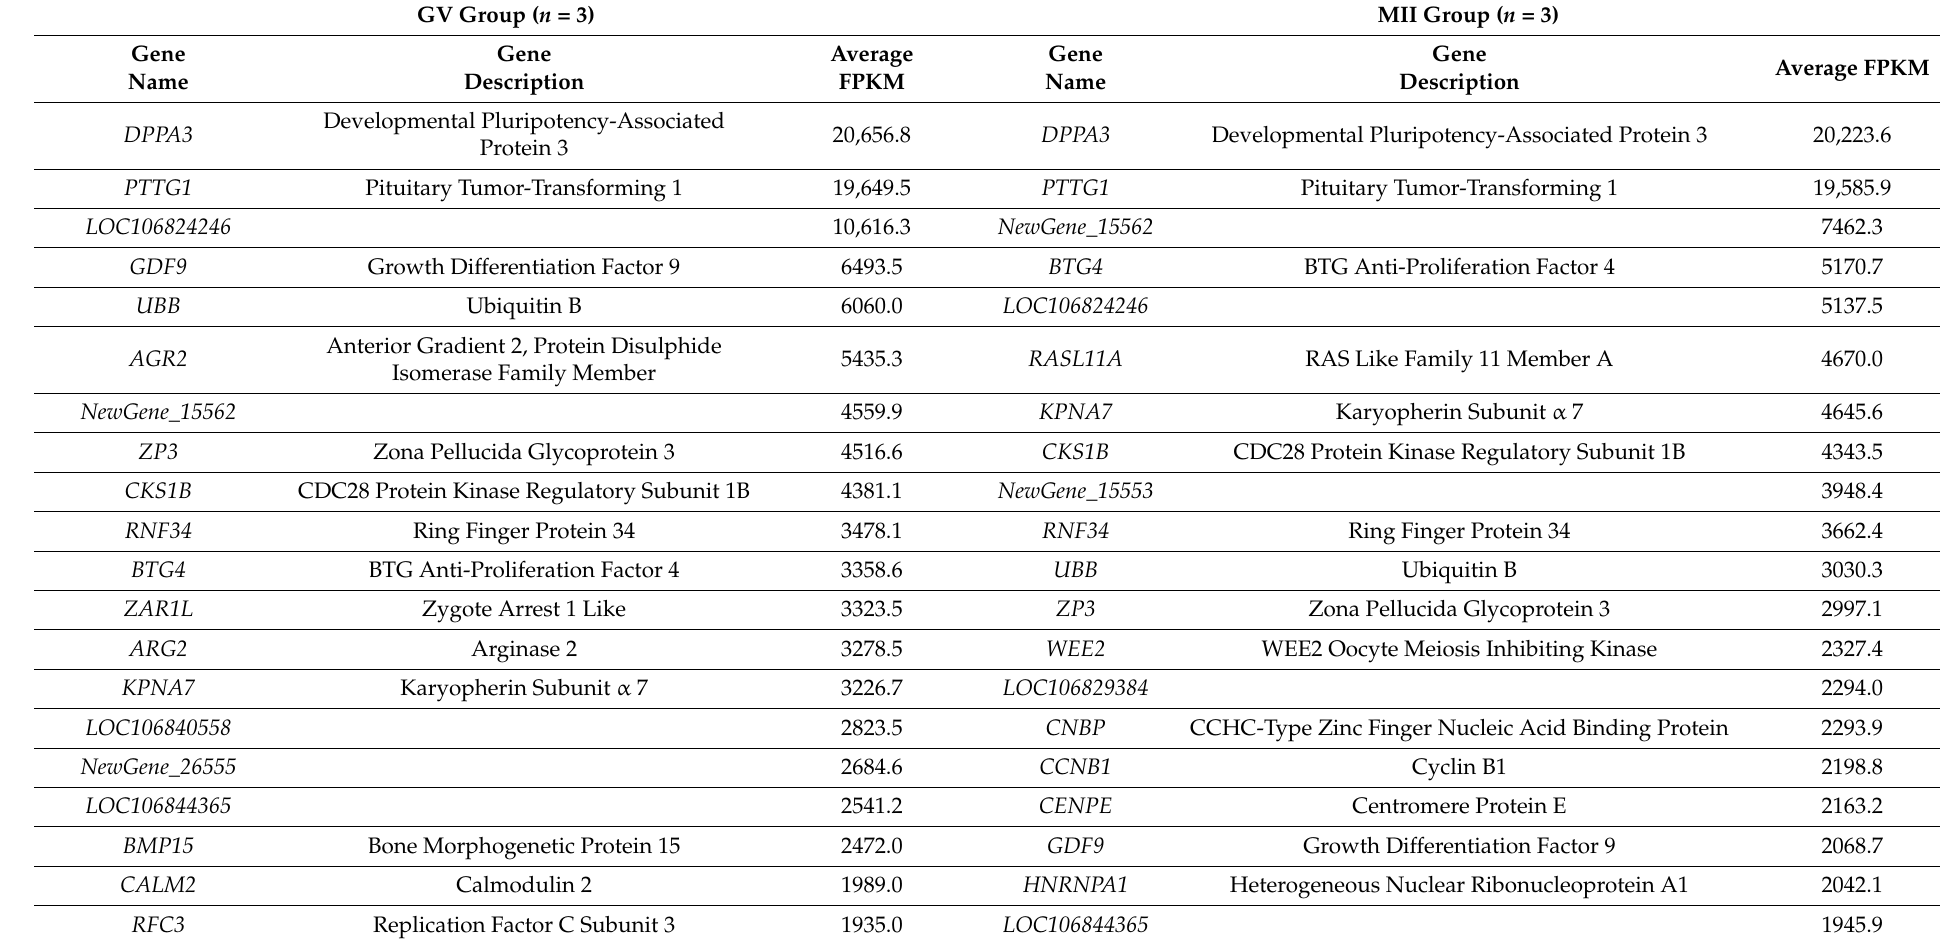
Table 3. The top 20 most abundantly expressed genes in the scRNA-seq profiles of each